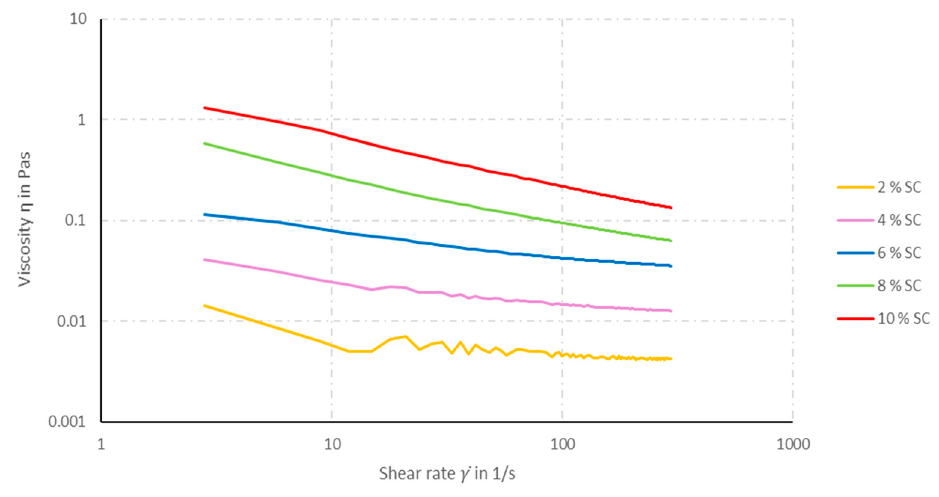
Figure 1. Viscosity of the coating solution as function of the SC with a constant CNT content of 10 wt% in the